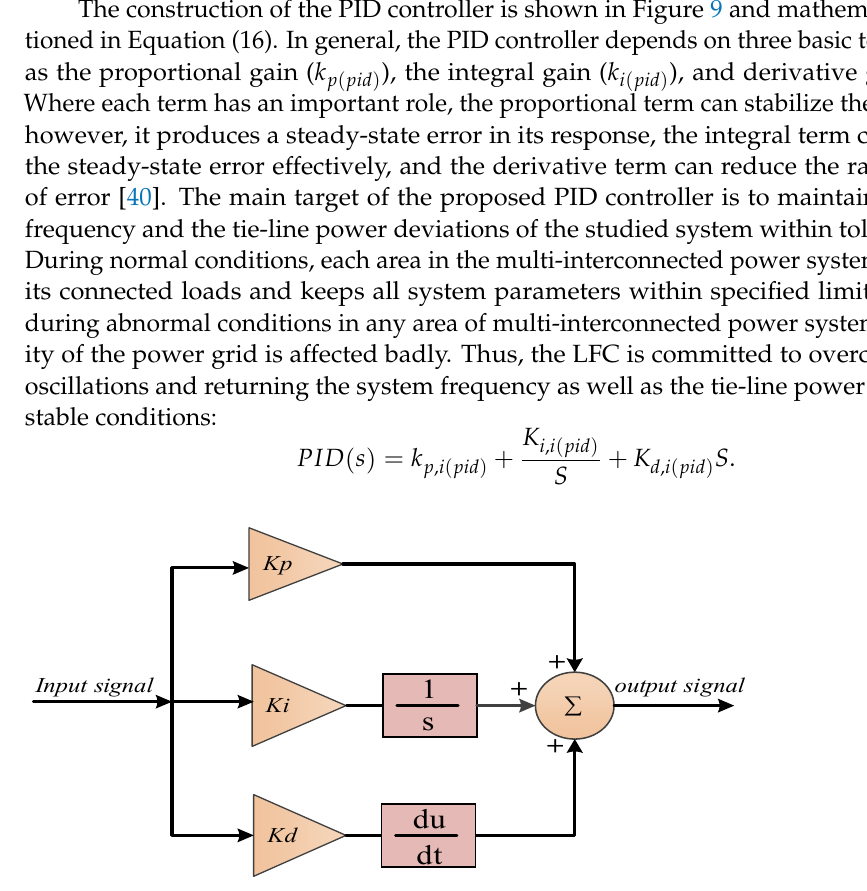
Figure 9. The structure of the PID